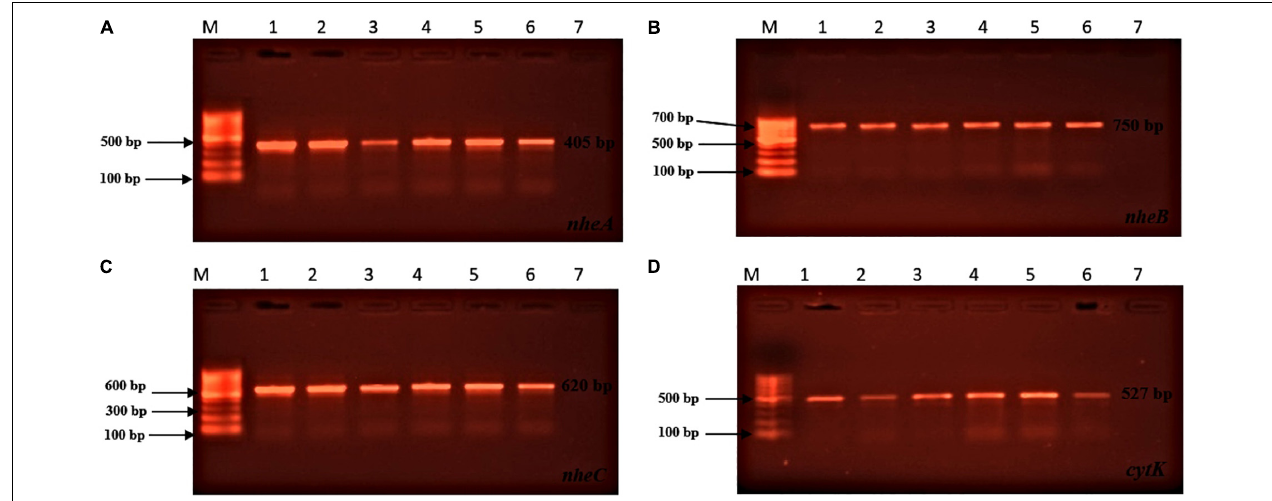
FIGURE 1 | Toxin genes of isolated Bacillus spp. by PCR test. (A) ( nheA gene, L1: 100 bp marker, L2: positive control, L3: sample 1, L4: sample 2, L5: sample 3, L6: sample 4, L7: sample 5, L8: negative control); (B) ( nheB gene, L1: 100 bp marker, L2: positive control, L3: sample 1, L4: sample 2, L5: sample 3, L6: sample 4, L7: sample 5, L8: negative control); (C) ( nheC gene, L1: 100 bp marker, L2: positive control, L3: sample 1, L4: sample 2, L5: sample 3, L6: sample 4, L7: sample 5, L8: negative control); (D) ( cytK gene, L1: 100 bp marker, L2: positive control, L3: sample 1, L4: sample 2, L5: sample 3, L6: sample 4, L7: sample 5, L8: negative